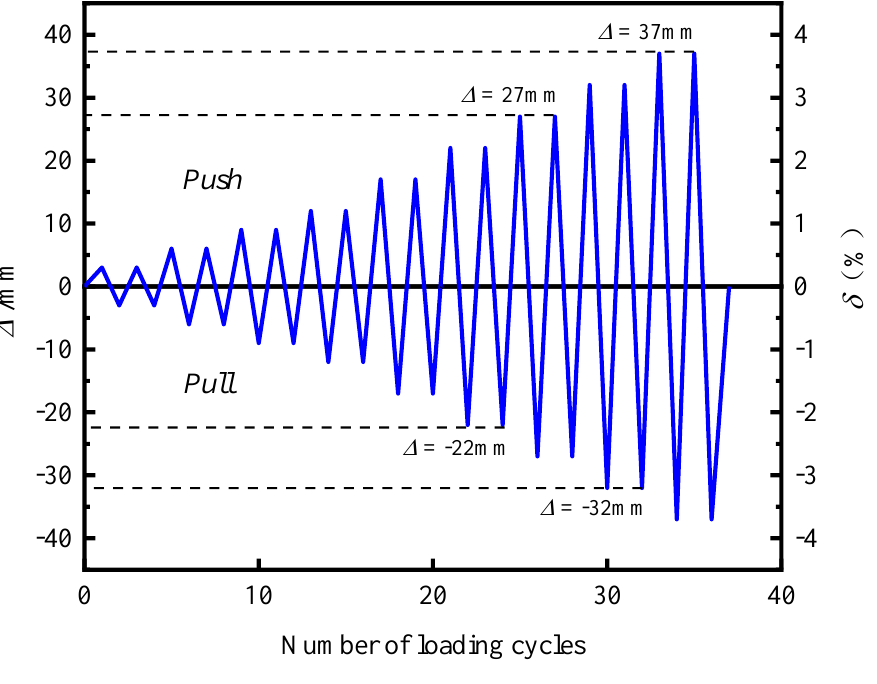
Figure 7. Loading